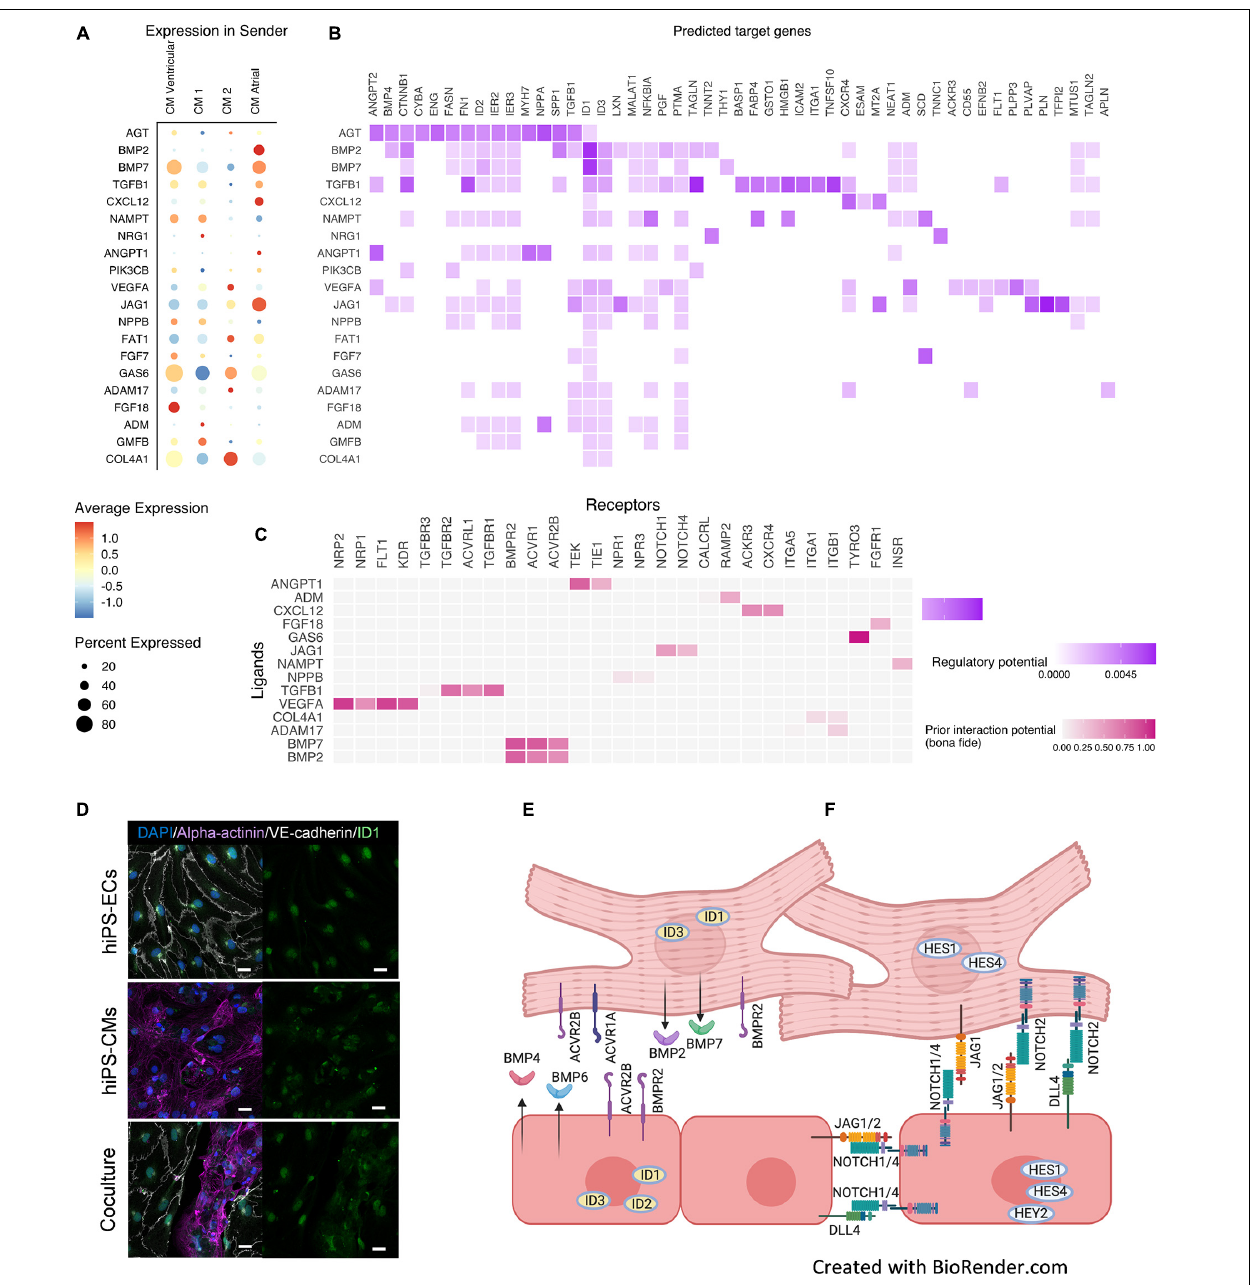
FIGURE 7 | Ligand-target gene analysis using NicheNet (Browaeys et al., 2020). Results are shown for the top 20 ligands. (A) Expression of top 20 ligands in sender cells (hiPS-CM). (B) Ligand–target matrix denoting the regulatory potential between sender (hiPS-CM) ligands and predicted receiver (hiPS-EC) target genes. (C) Ligand-receptor interactions between ligands from hiPS-CMs and receptors expressed from hiPS-ECs. (D) Immunofluorescence staining of ID1 in monoculture hiPS-ECs, monoculture hiPS-CMs, and hiPS-EC/hiPS-CM co-culture (scale bar 20 µ m). Predicted cell-cell interactions in co-culture hiPS-EC/hiPS-CM in (E) BMP-pathway, where increased expression of BMP2/7 ligands is seen in hiPS-CMs and BMP4/6 in hiPS-ECs in co-culture as well as an increased expression of the ID-genes in both cell types, (F) Notch-pathway, where the ligand JAG1 is increased in hiPS-ECs and hiPS-CMs and JAG2 and DLL4 in hiPS-ECs, in